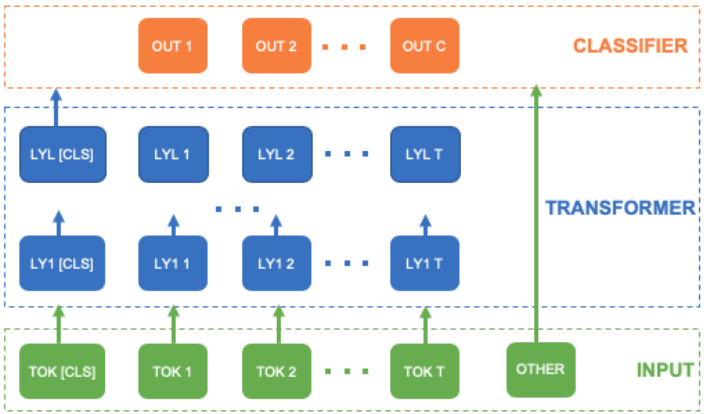
Figure 2. Fine-tune model architecture. Input tokens are converted to contextual representations using a transformer model. The aggregate representation from the last layer L and other input features are used for